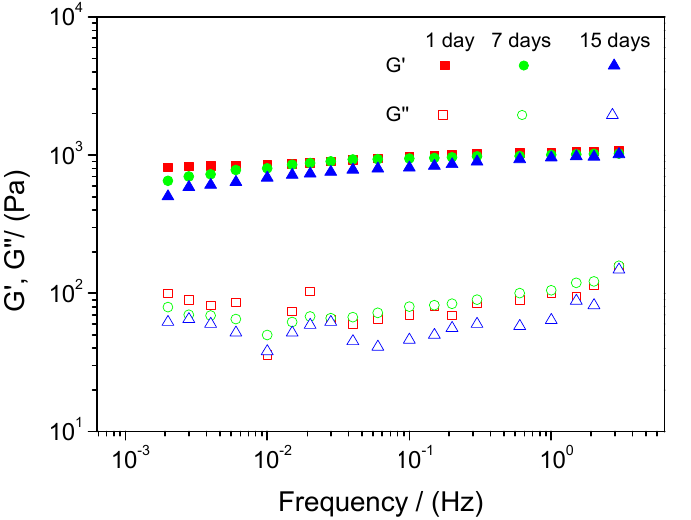
Figure 6. Frequency sweep for an emulsion at 2.0 wt% of soy protein isolate, pH 2 and processed at 120 PSI.